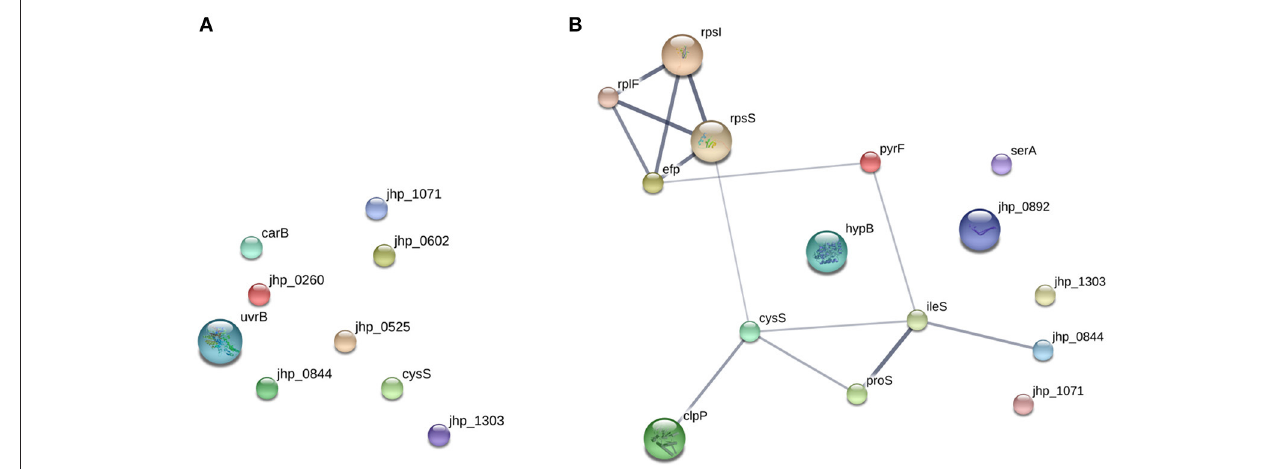
FIGURE 5 | STRING protein-protein interaction network of proteins from PEAKS refined data. The gene names correspond with the proteins that were recovered from (A) levofloxacin and (B) metronidazole-sensitive and resistant strains.